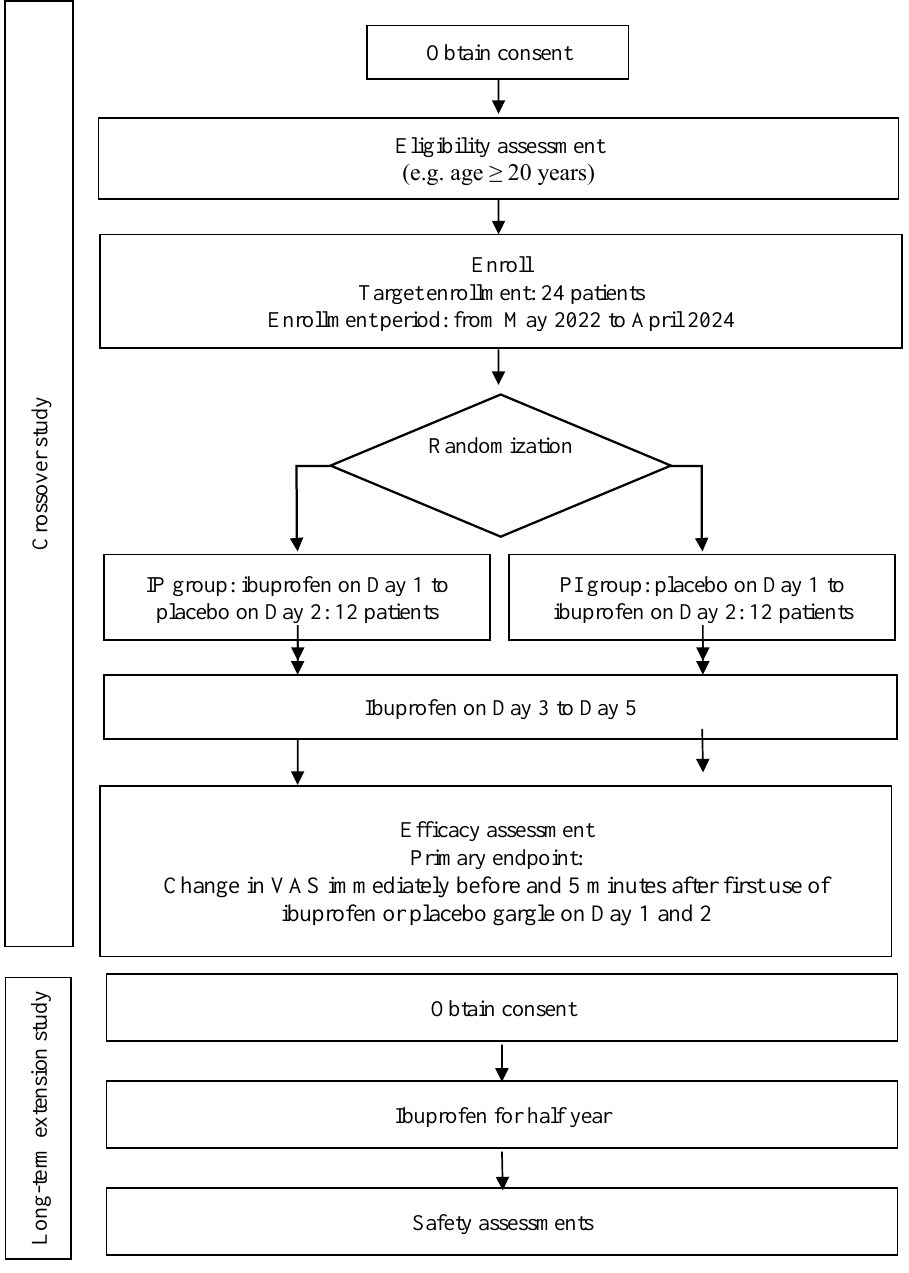
Figure 1. Flowchart of the study design. VAS: visual analogue scale, IP: ibuprofen to placebo, PI: placebo to